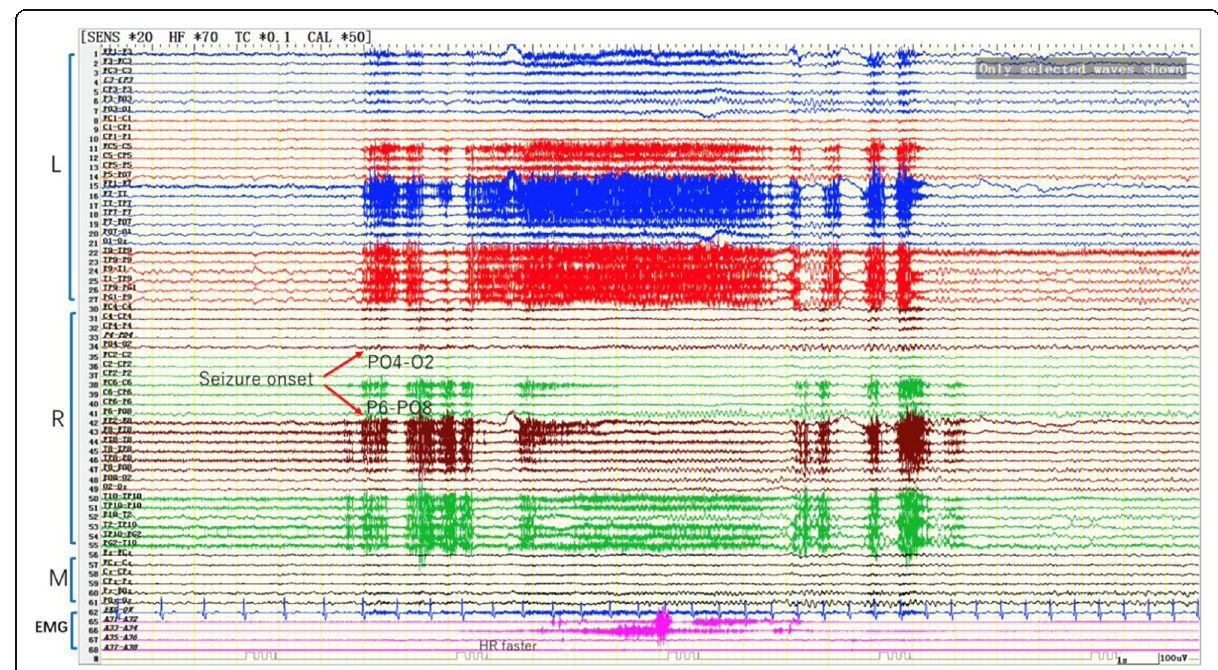
Fig. 4 Ictal scalp EEG monitoring with the high-density international 10% system. The red arrows indicate EEG onset on P4-PO2, P6-PO8 electrodes, with simultaneously increased heart